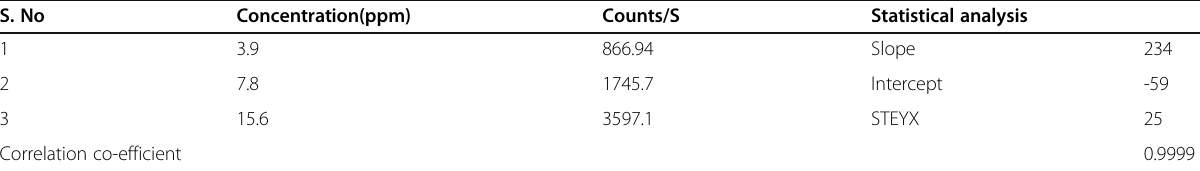
Table 13 System suitability results of